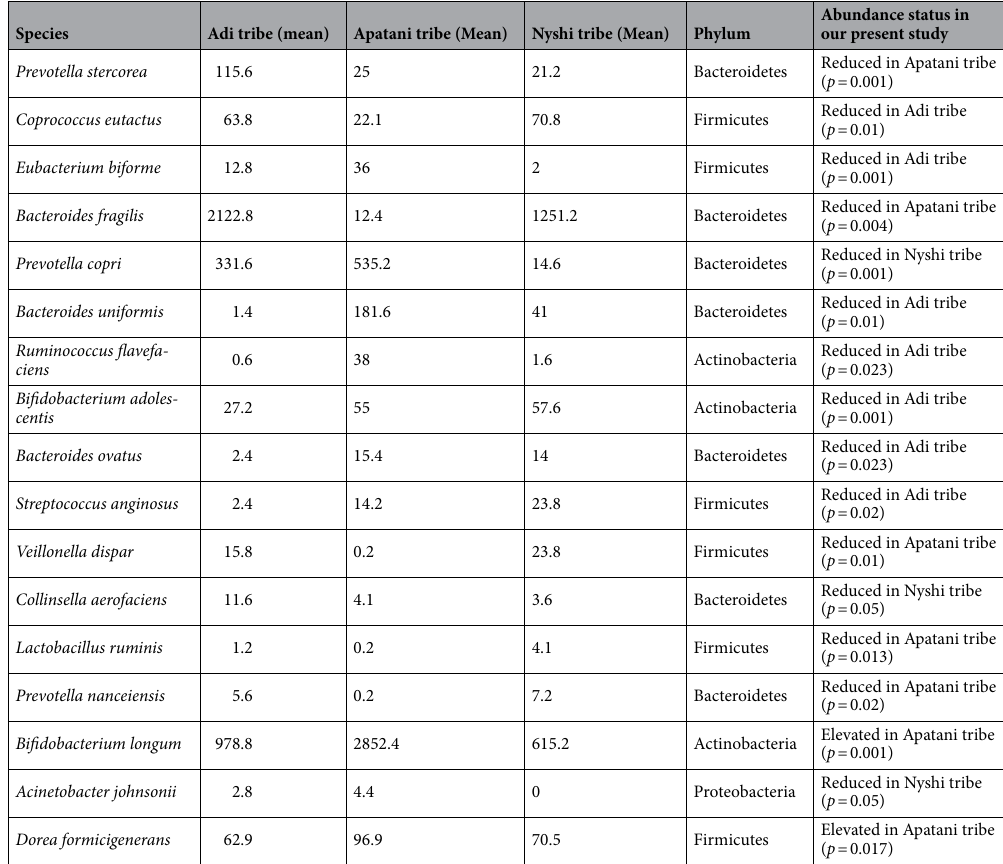
Table 2. Statistically significant different bacterial species in the Adi tribe( Group 1), Apatani tribe(Group 2) and Nyshi tribe(Group